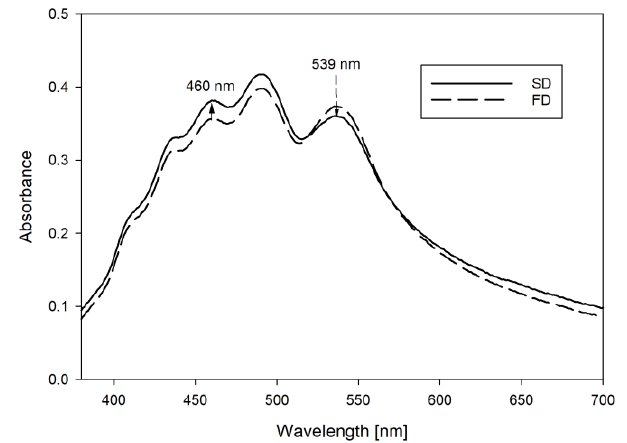
Figure 4. UV/Vis spectra of carrot concentrate powder after spray drying (solid line) and freeze drying (dashed